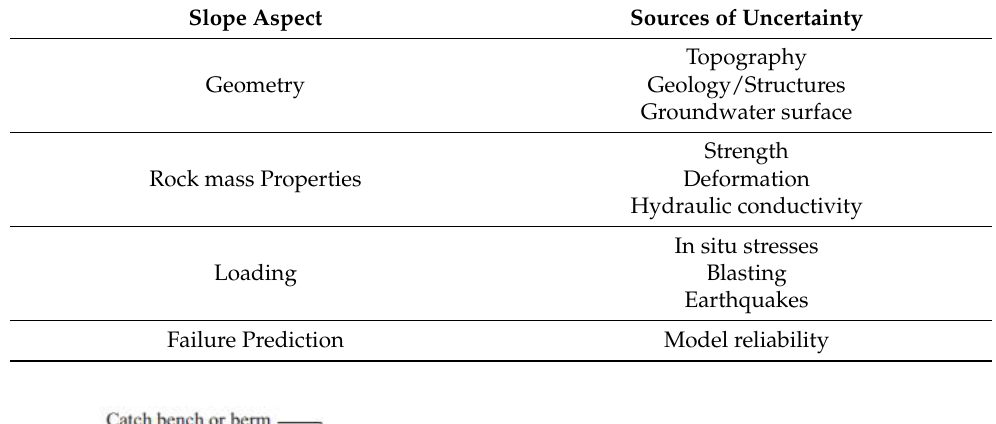
Table 2. Sources of uncertainty in rock slope failure.